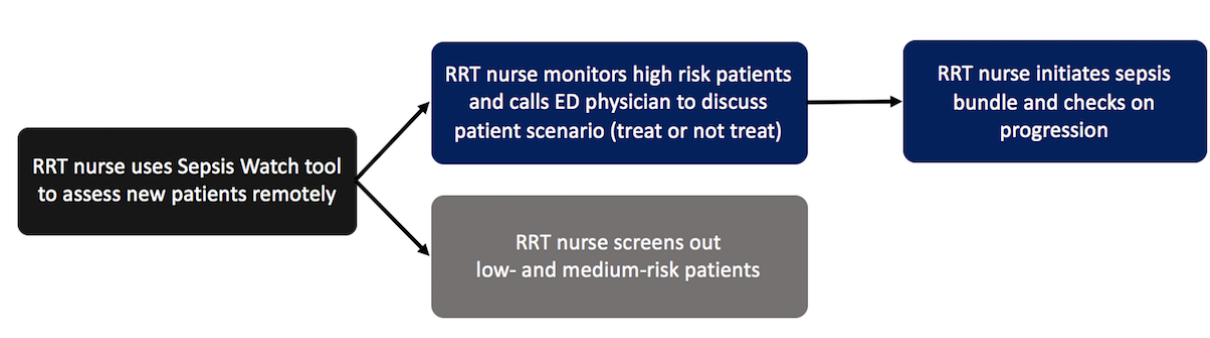
Figure 1. Sepsis Watch workflow. ED: emergency department; RRT: rapid response